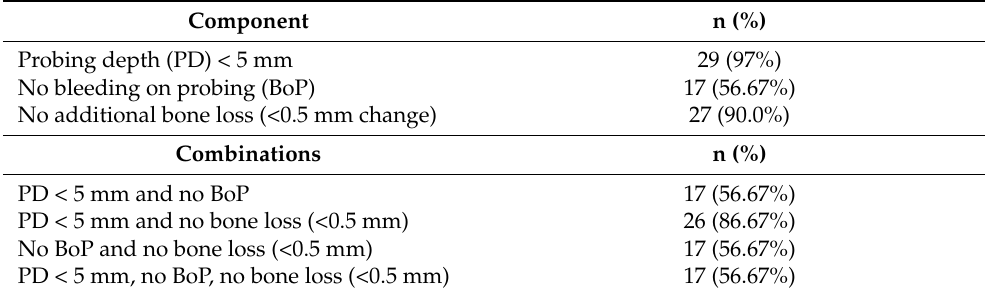
Table 2. Components and combinations of the disease resolution outcome at the 6-month evaluation, expressed as number of implants (n) and percentage (%).